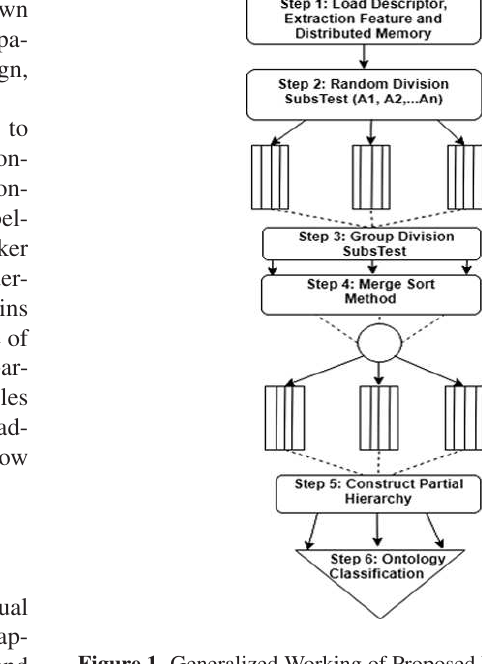
Figure 1. Generalized Working of Proposed